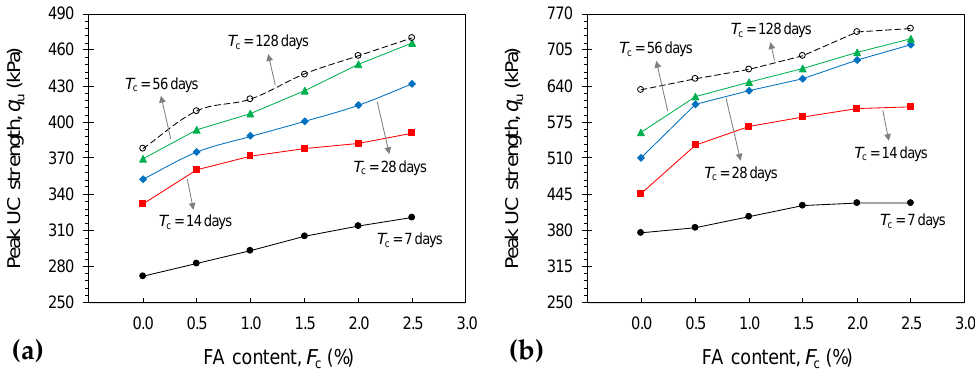
Figure 5. Variations of peak UC strength q u against FA content for the samples tested at various curing times: ( a ) M 1.5 F y T z ; ( b ) M 2.5 F y T z ( y = {0, 0.5, 1.0, 1.5, 2.0, 2.5} and z = {7, 14, 28, 56, 128}).